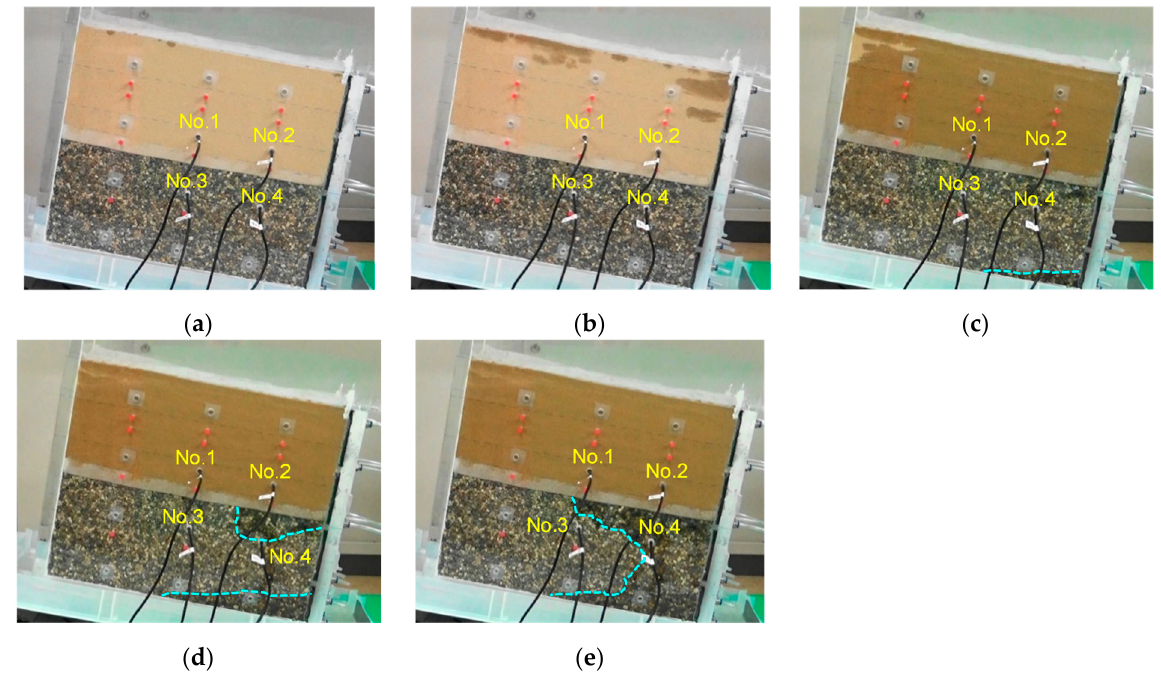
Figure 7. Occurrence of rainfall infiltration as a function of the elapsed time in Case 1: ( a ) initial condition; ( b ) after 60 min; ( c ) after 200 min; ( d ) after 210 min; ( e ) after 360 min.